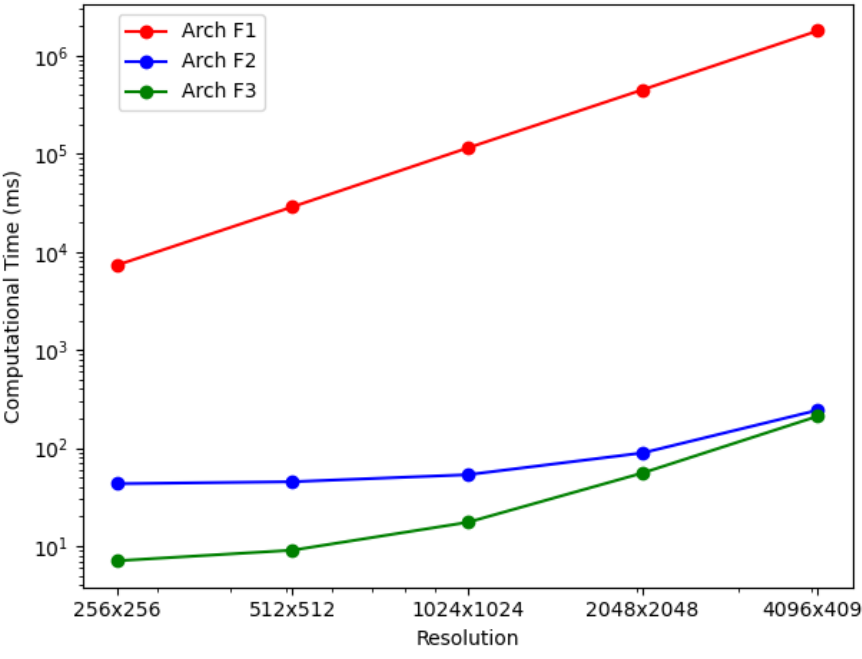
Figure 8. BP-VISAR frame generation time with full-aperture processing in overlapped mode ( α =